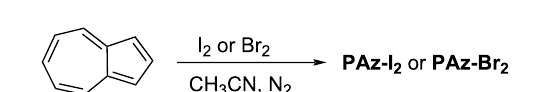
formula representation C 10 H 6 (I 2 ) 0.4 for PAZ-I 2